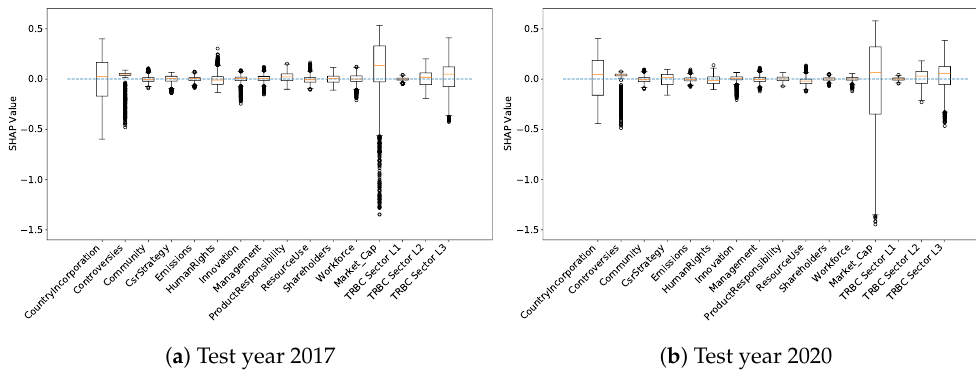
Figure 9. SHAP values distribution.